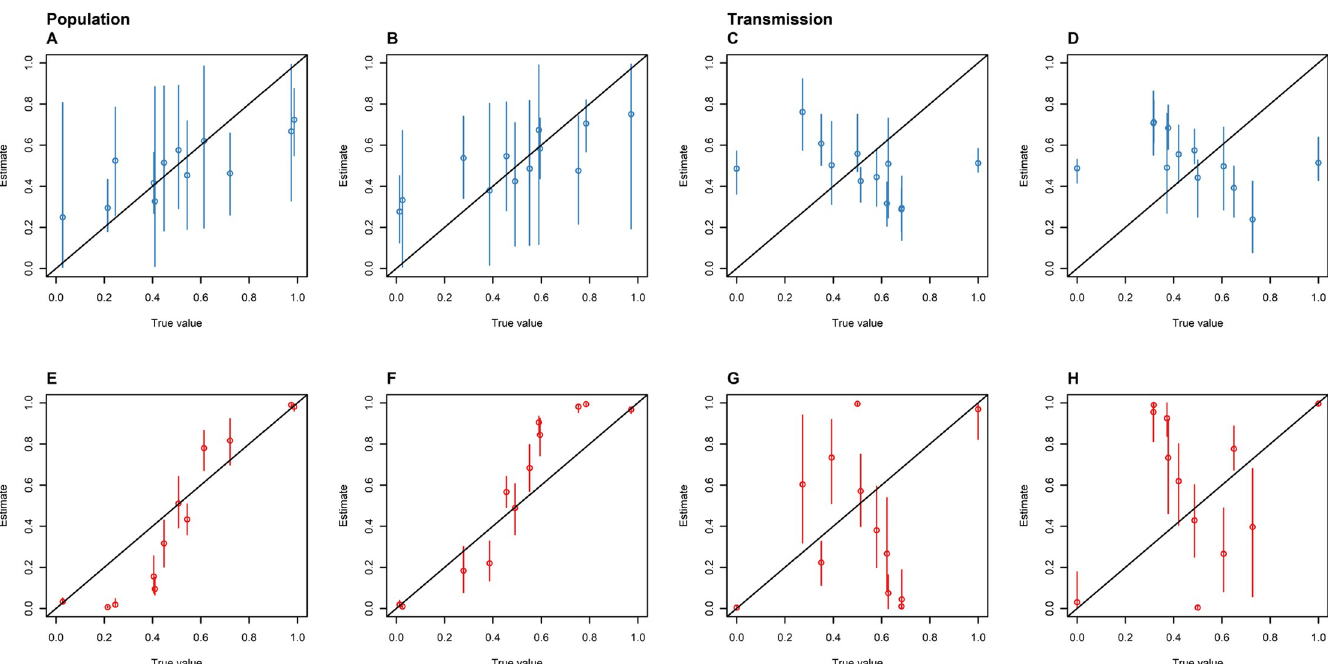
Fig 13. The proportion of time spent in the animal (A and E) and human (B and F) host populations, and the proportion of inter-population transmissions made up of animal-to-human (C and G) and human-to-animal (D and H) transmissions as estimated by the SC (blue: A-D) and DTA (red: E-F) models versus the true parameters for 12 EPTI simulated outbreaks that 100 isolates were randomly sampled from. The diagonal line represents accurate estimates of the sampled outbreaks, the dots represent the mean, and the error bars represent the 95% HPD interval.